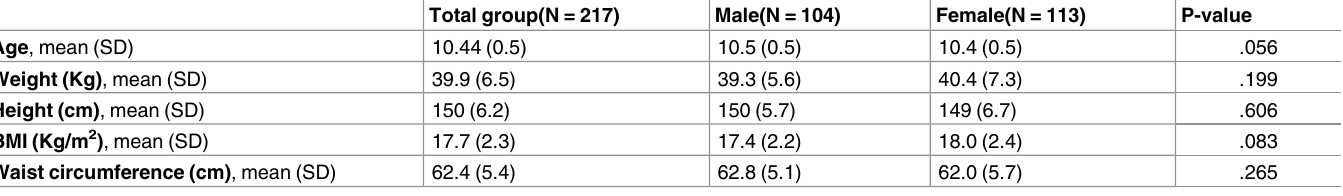
Table 1. Participants